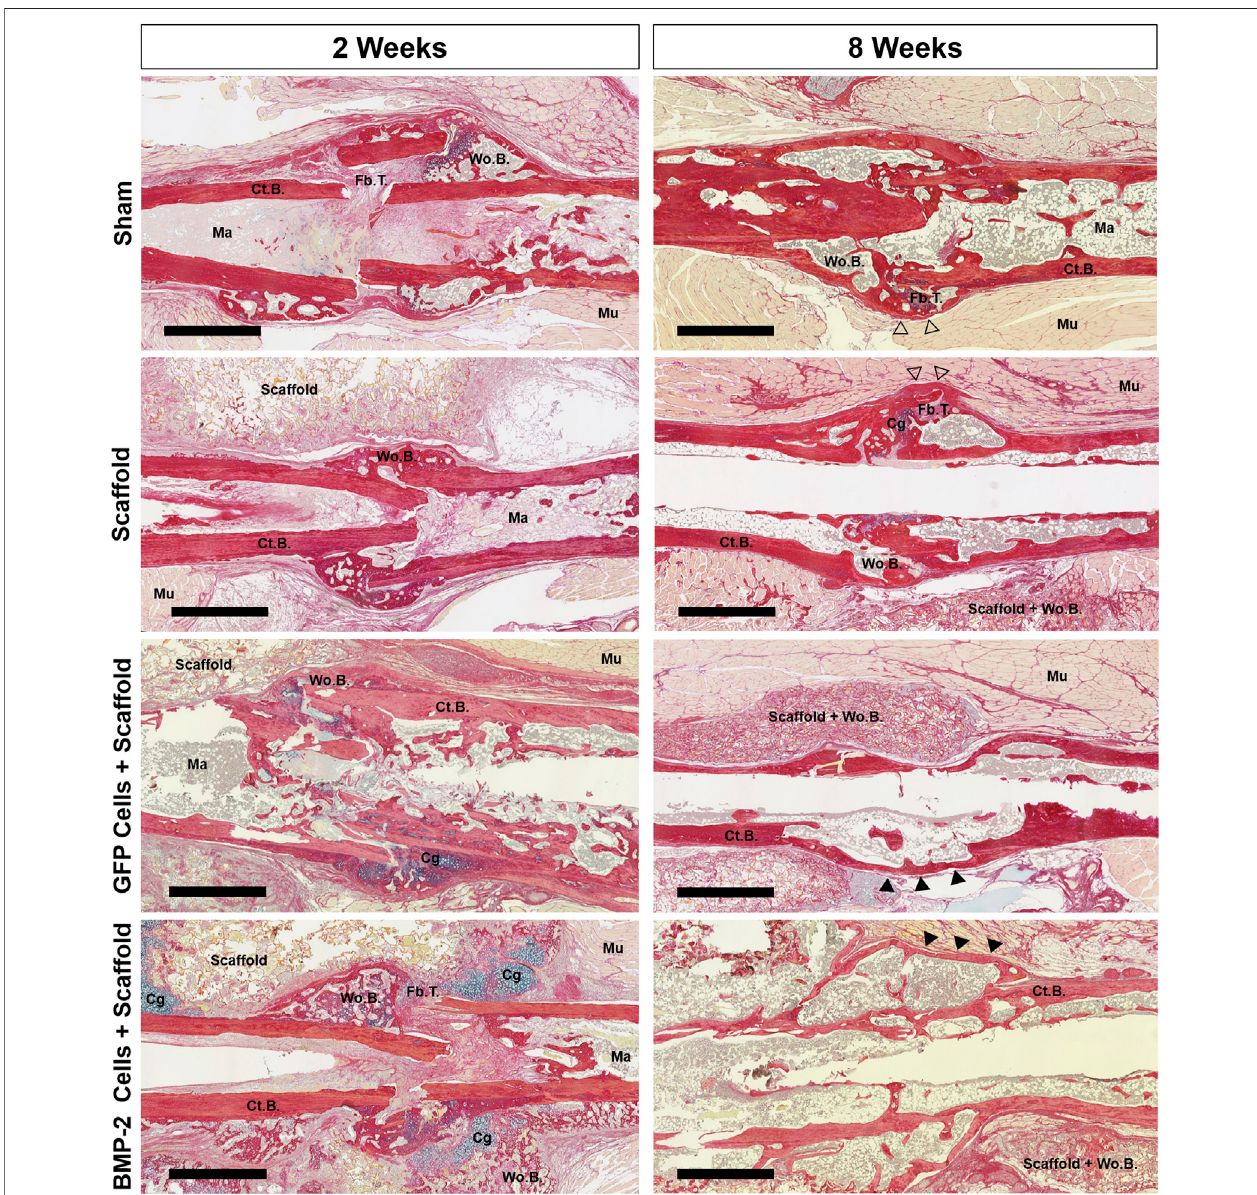
FIGURE5| Representativepicrosiriusred/alcianbluestainingofthenonunionsiteofallgroupsat2and8 weekspostimplantation.Boththescaffoldonlyandsham groups displayed early woven bone and fi brous tissue, followed by additional bridging and bone formation between 2 and 8 weeks. At 8 weeks, the callus had some pocketsofwovenboneatastillvisiblefracturesite(openarrowheads).WhiletheGFP+grouphadsomecartilage,itwasminimalandresultedinbridginginallanimalsby 8 weeks. At 2 weeks, 6 of the 7 BMP-2+ groups displayed the cartilage both surrounding the nonunion site and within the surrounding scaffold. After 8 weeks, bridgingwasvisuallyachievedinallBMP-2sampleswithmineralin fi ltrationintothesurroundingscaffolds.Corticalbridgingwasdenotedby fi lledarrowheads.Scalebars denote 1 mm. Cg, cartilage; Ct.B, cortical bone; Fb.T, fi brous tissue/other; Ma, marrow; Mu, muscle; Wo.B, woven